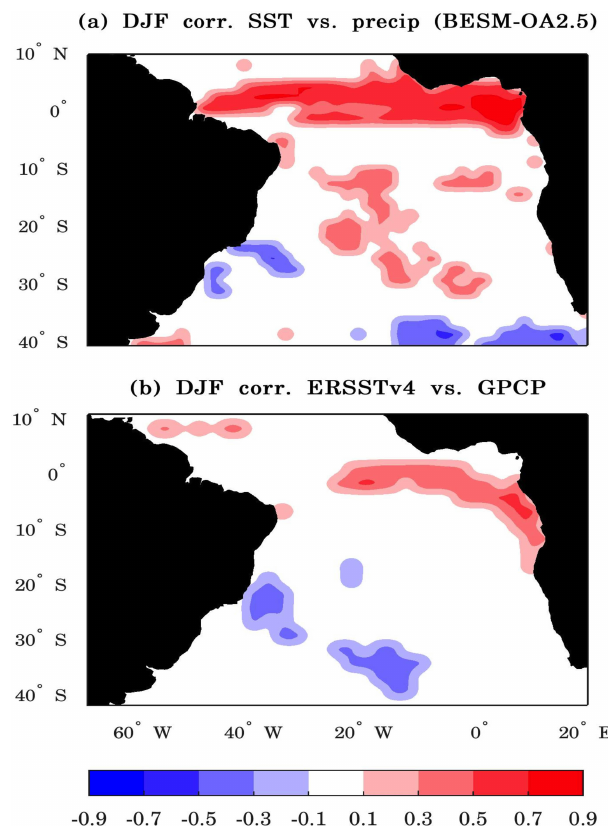
Figure 19. Spatial maps with the correlation between SST and pre- cipitation (seasonal average DJF) over the South Atlantic Ocean (40 ◦ S–10 ◦ N, 70 ◦ W–20 ◦ E) computed by (a) BESM-OA2.5 over the period 1971–2002 and (b) based on reanalysis over the period 1979–2010. Shaded areas are statistically significant at the 95% confidence level (based on two-tailed Student’s t